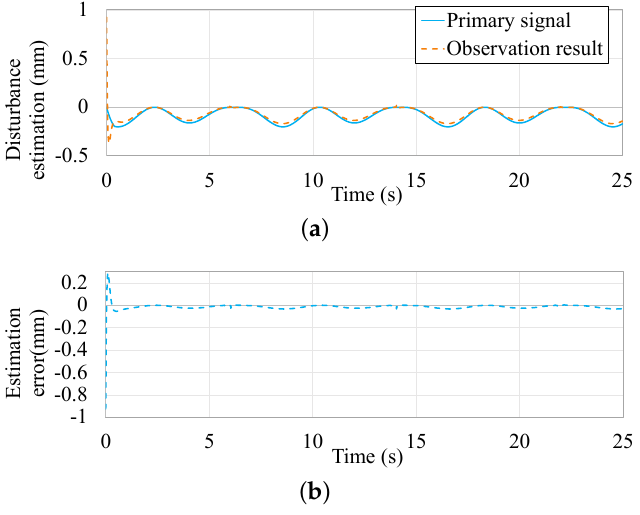
Figure 6. Observation result of ASMDO with d 2 . ( a ) Observing result based on the ASMDO. ( b ) Ob- serving error based on the